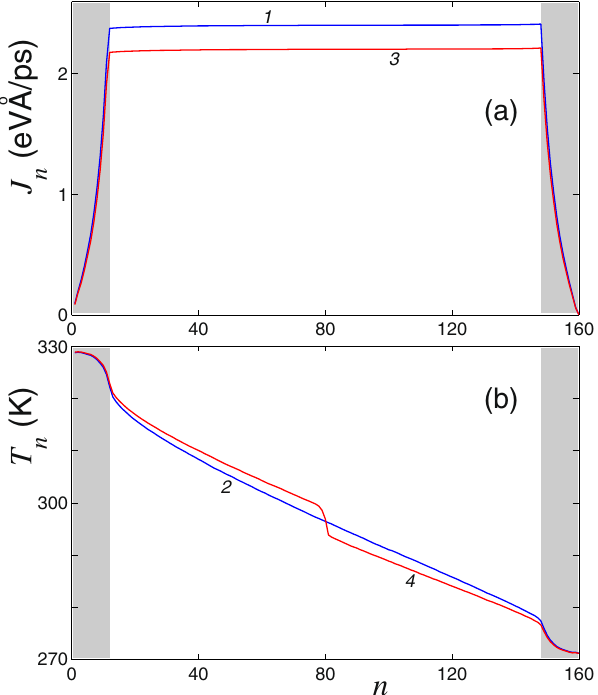
Figure 9. Spatial distribution of ( a ) local heat flux J n and ( b ) temperature T n along the nanoribbon with and without point defect. The nanoribbon width is D = 1.72 nm, and its length is L = 68 nm ( N = 160). Thermostat temperature from the left end of the nanoribbon is T + = 330 K, and from the right – T − = 270 K. Grey color marks the end regions corresponding to the interaction of the nanoribbon with thermostat. Curves 1 and 2 correspond to the ideal nanoribbon, and curves 3 and 4 correspond to the nanoribbon with the point defect V 2